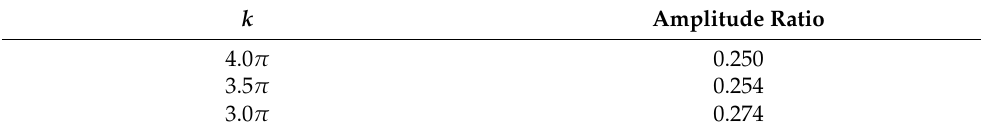
Figure 8. Amplitude envelopes at different values of k : ( a ) 3 π , ( b ) 3.5 π , ( c ) 4 π . The fixed parameters are: A = 200, Re = 100. Table 2. The amplitude ratios at different